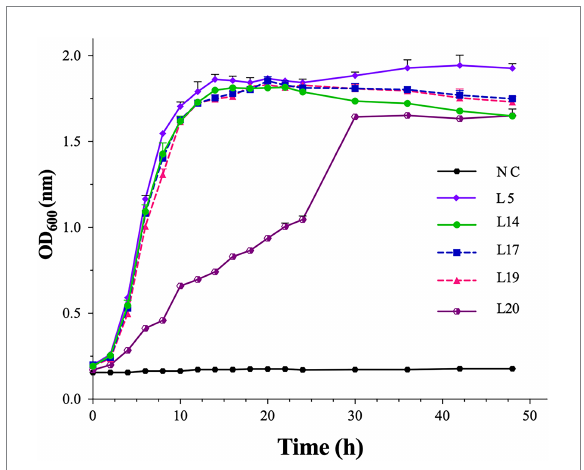
FIGURE 4 The growth curves of the five most probiotic potential isolates. The optical density at 600 nm (OD 600 nm) of the cultures. NC, sterile MRS medium. Error bars refer to the SD of the 3 replicates of each